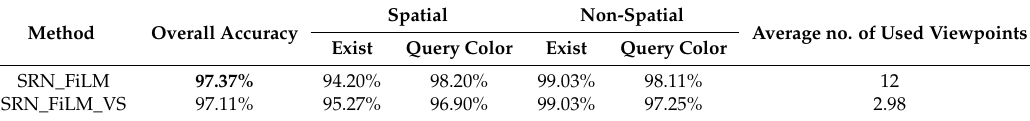
Table 2. Evaluation results for Multi-view-CLEVR_12views_ CG